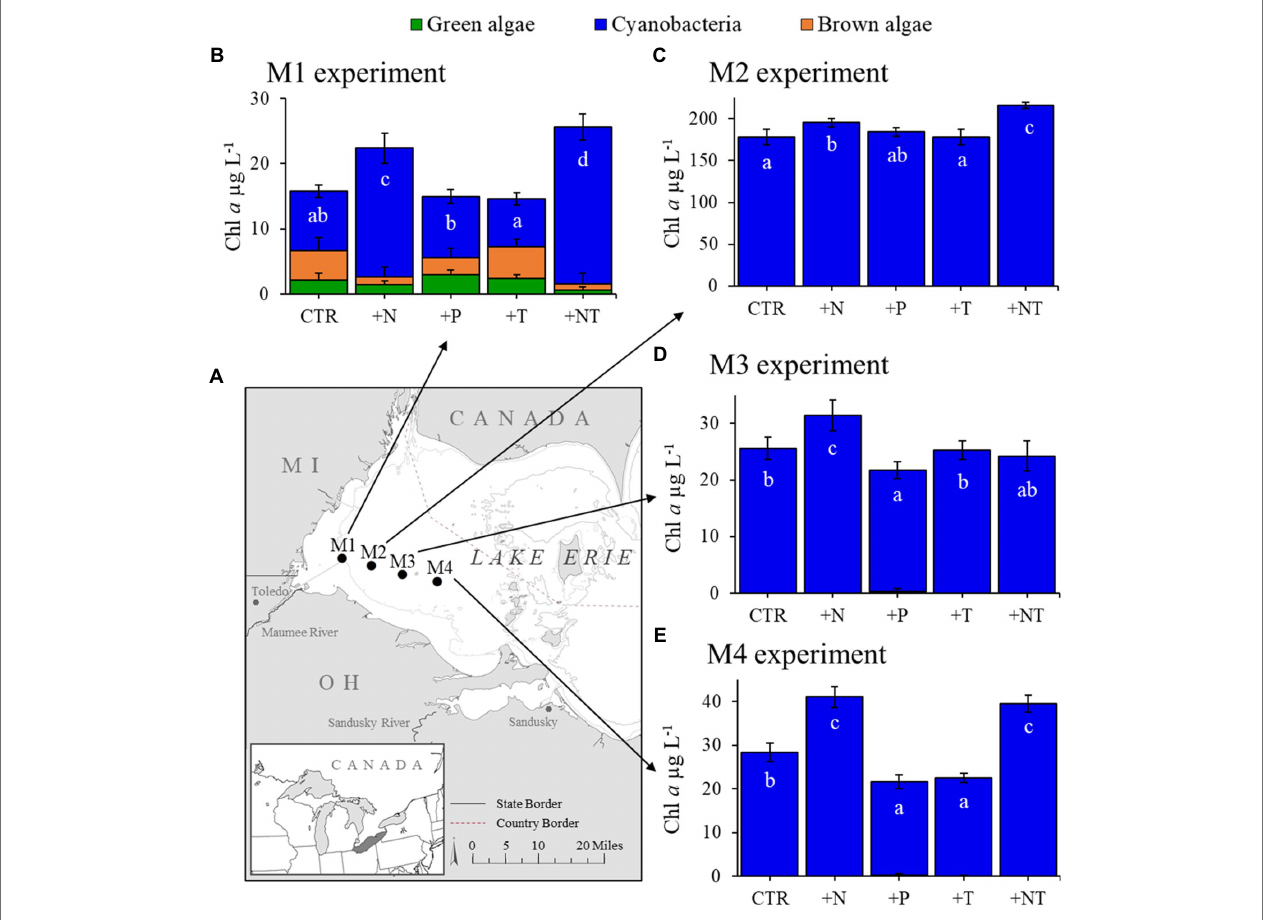
FIGURE 2 | (A) Sampling locations of for experiments in Lake Erie’s western basin. (B–E) Response of the fluoroprobe-derived algal groups to experimental treatments (CTR, Control; +N, Nitrate addition; +P, Orthophosphate addition; +T, elevated incubation temperature). Letters indicate significant differences in cyanobacteria abundance between treatments, bars with shared letters are not significantly